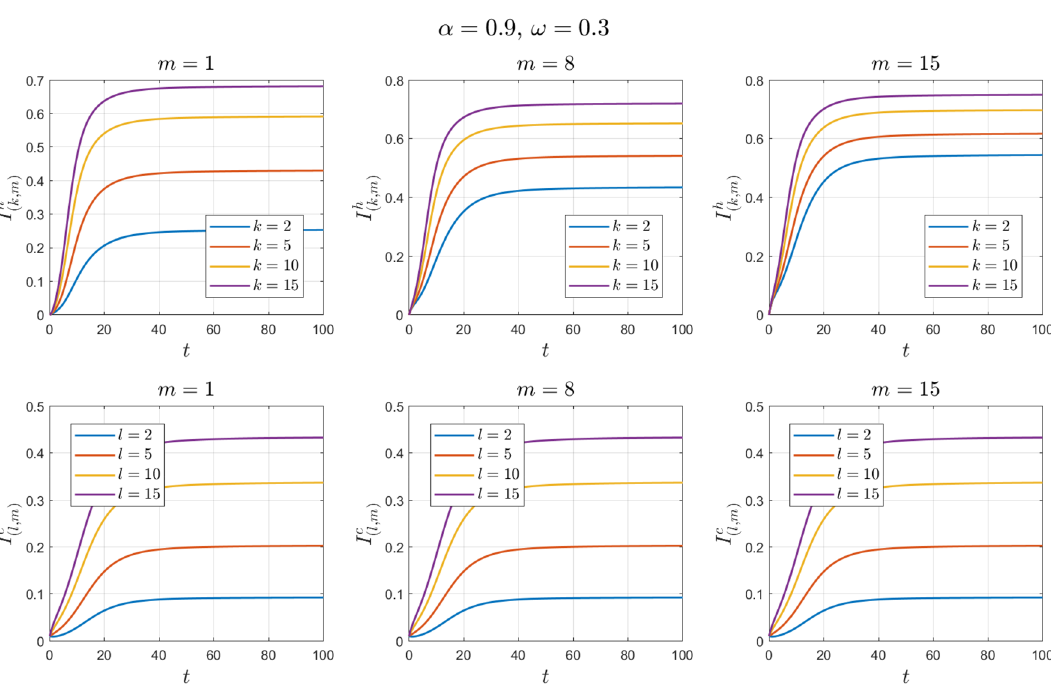
Figure 15. Numerical solutions of Example 5 for α = 0.9 and ω = 0.3